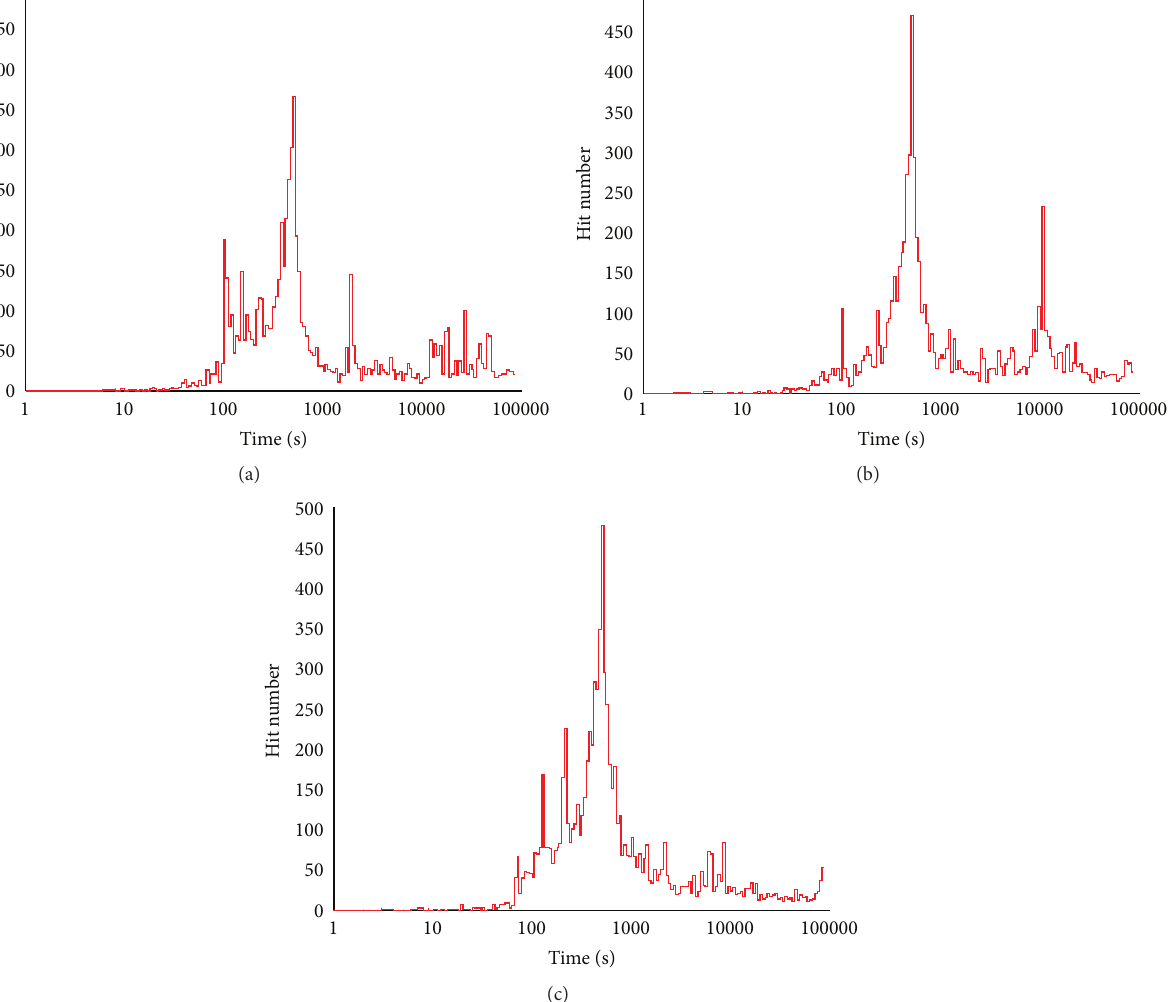
Figure 9: Change of AE hit number with the tensile loading time for matrix and interface damage in three specimens: (a) specimen of number 1; (b) specimen of number 2; (c) specimen of number